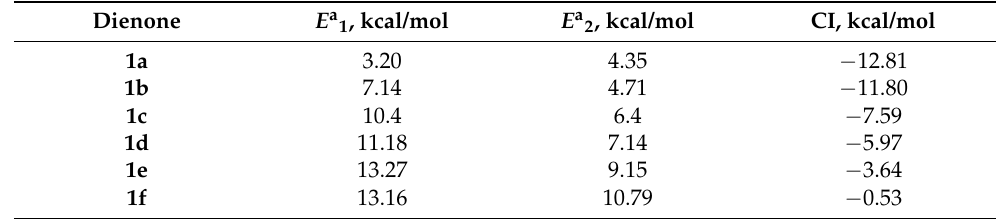
Table 6. E , E -to-CI (1) and E , Z -to-CI (2) activation energies and CI depths for 1a – f in the S1 state.